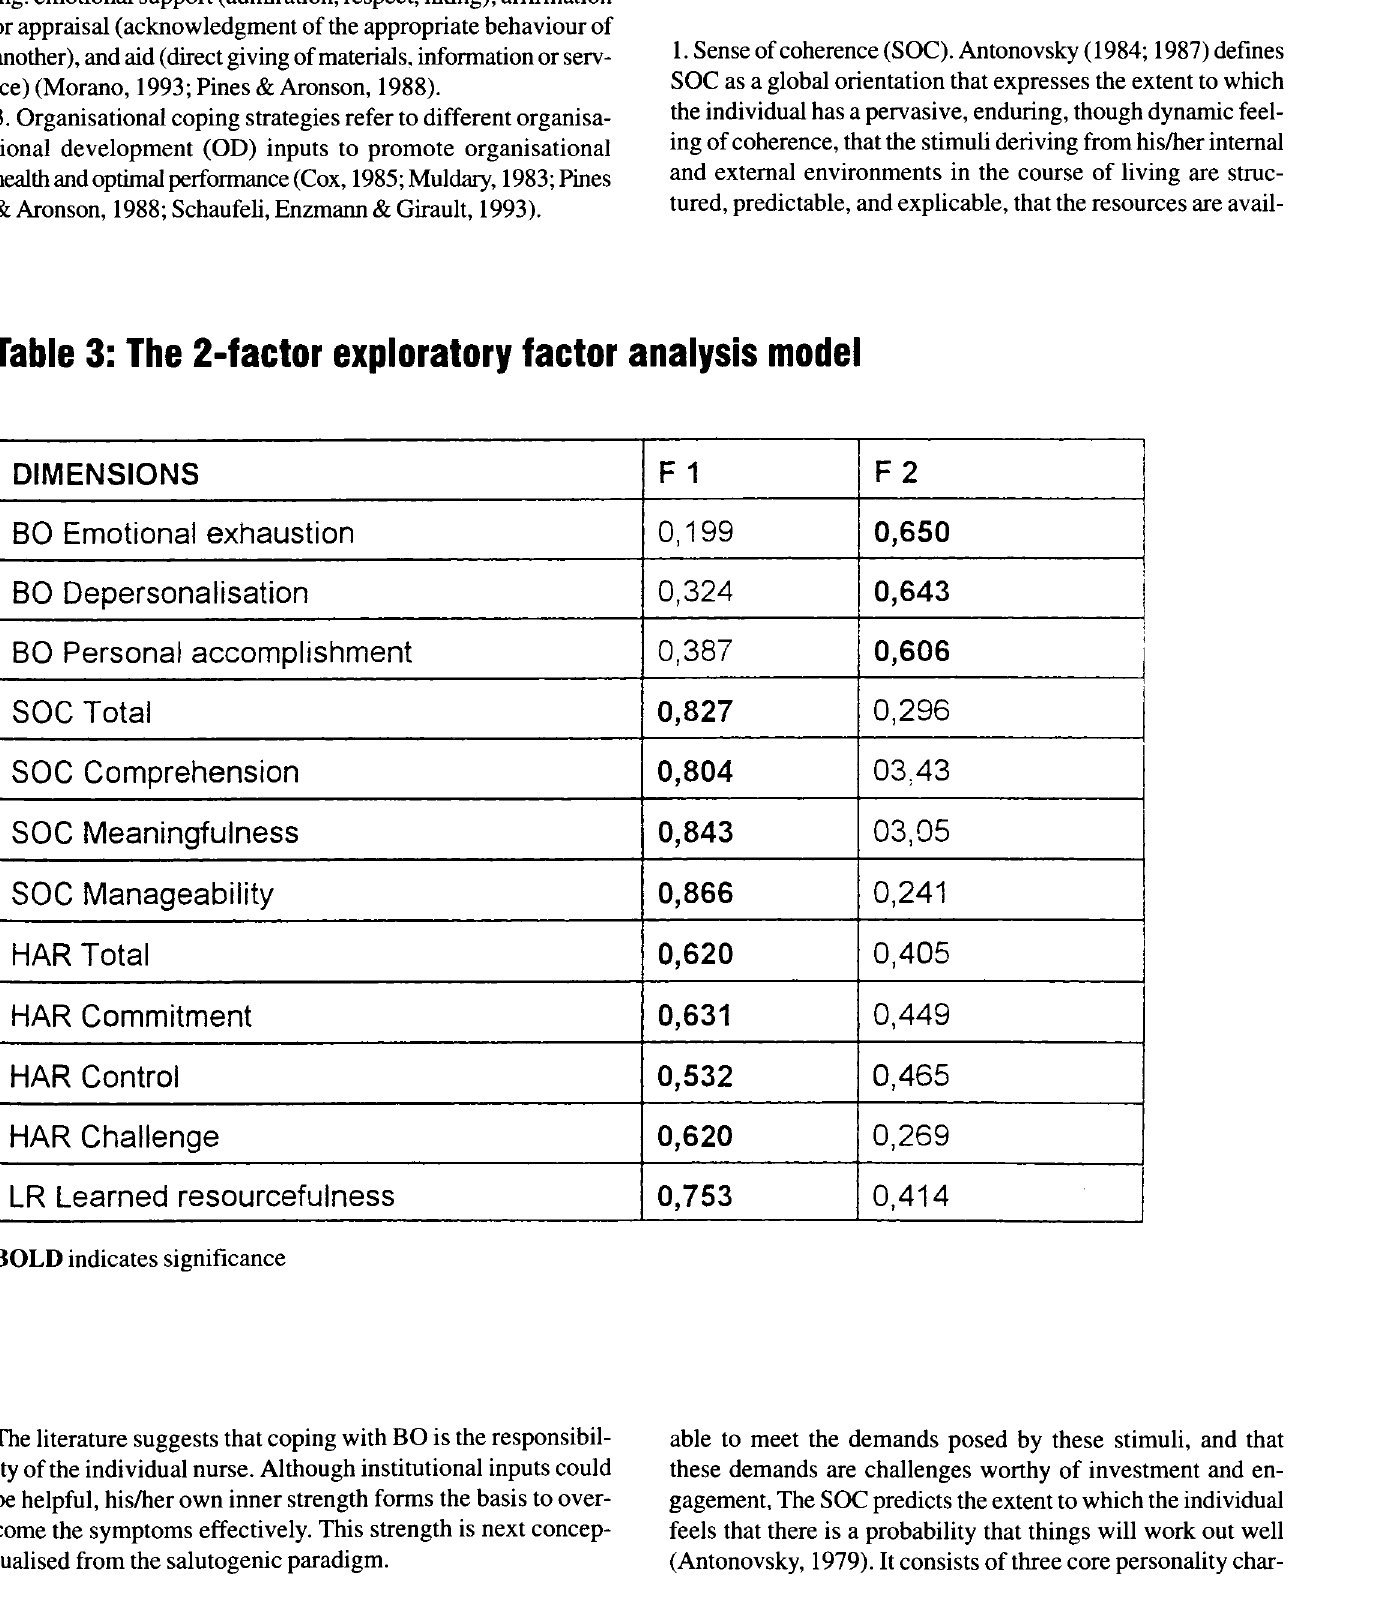
Table 3: The 2-factor exploratory factor analysis model